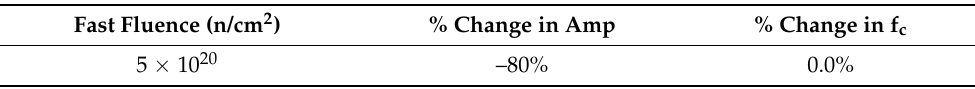
Table 5. Performance metrics for the bismuth titanate (BiTi) sensor. The fast fluence is calculated for the last measured acoustic response of the sensor considering neutrons greater than 1